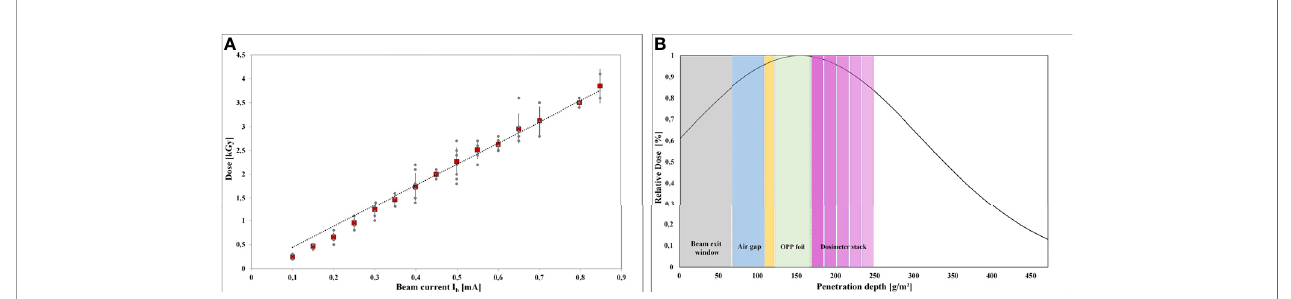
FIGURE 3 | Dose measurements and depth dose distribution: (A) Linear correlation between the adjusted beam current and the absorbed dose in the intended dose range from 0 to 3.5 kGy. The red rectangles show the mean values. (B) Schematic illustration the depth dose distribution in the OPP-system, simulated by a stack of 5 dosimeter